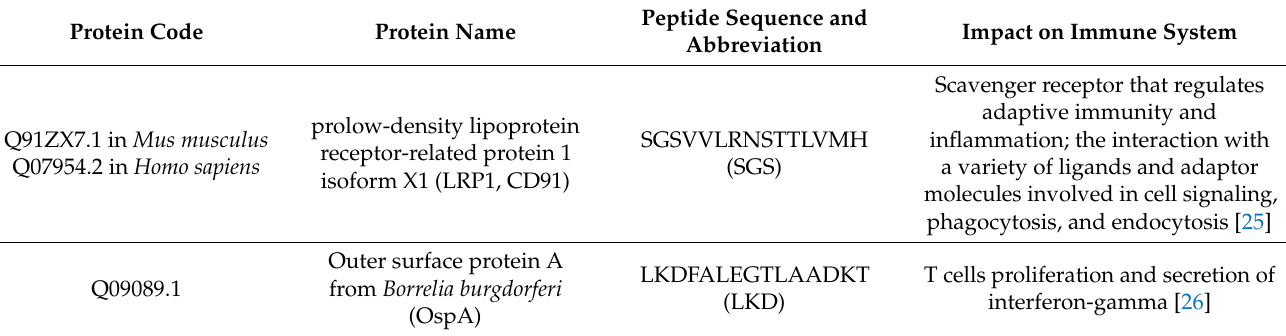
Table 1. Characteristics of designed